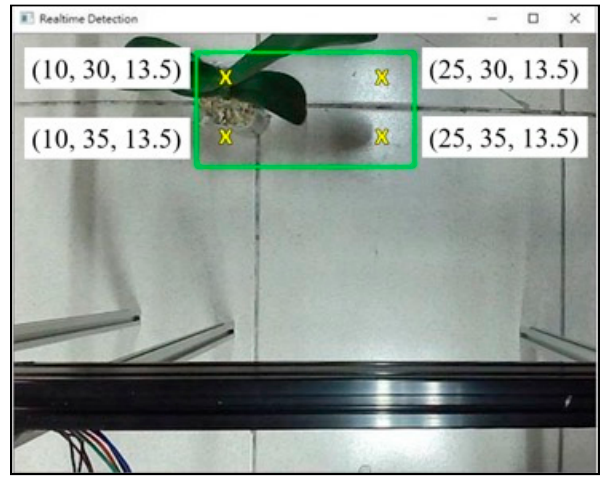
Figure 22. Target of Condition 2.